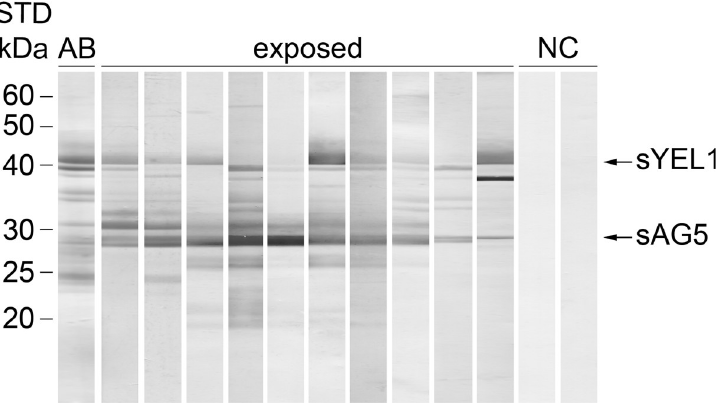
Fig 1. Immunoblot profile of P . orientalis salivary antigens. P . orientalis salivary proteins were electrophoretically separated under non-reducing conditions. Western blot analysis was performed with ten anti-SGH ELISA